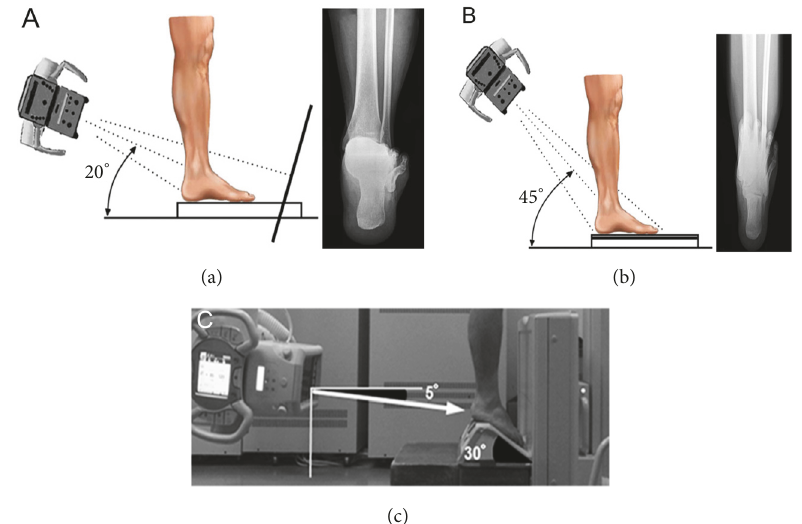
Figure 1: (a) The inclinationangle of the beam is 20 ∘ tothe floor. The film cassetteis perpendiculartothe centralbeam of the radiation source. (b) The film cassette is lying on the floor and the subject is standing on the film cassette. The inclination angle of the beam is 45 ∘ to the floor. (a) and (b) are reproduced from Reilingh et al. 2010 [5] [under the Creative Commons Attribution License/public domain]. (c) Participants stood on a radiolucent platform with equal weight on both feet. This platform was flat in the rear part and inclined by 30 ∘ in the front part, so that the midfoot and forefoot of participants were planter-flexed. The X-ray beam was oriented down 5 ∘ from the horizontal position. (c) is reproduced from Ikoma et al. 2013 [6] [under the Creative Commons Attribution License/public domain].